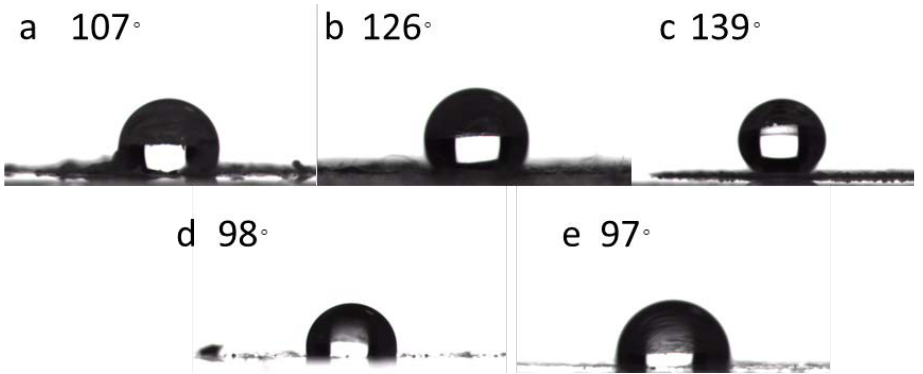
Figure 7. Water contact angle experiment of xerogel films 1 from different solvents: ( a ) acetone, ( b ) 1,4-dioxane, ( c ) ethanol, ( d ) DMF and ( e ) DMSO.